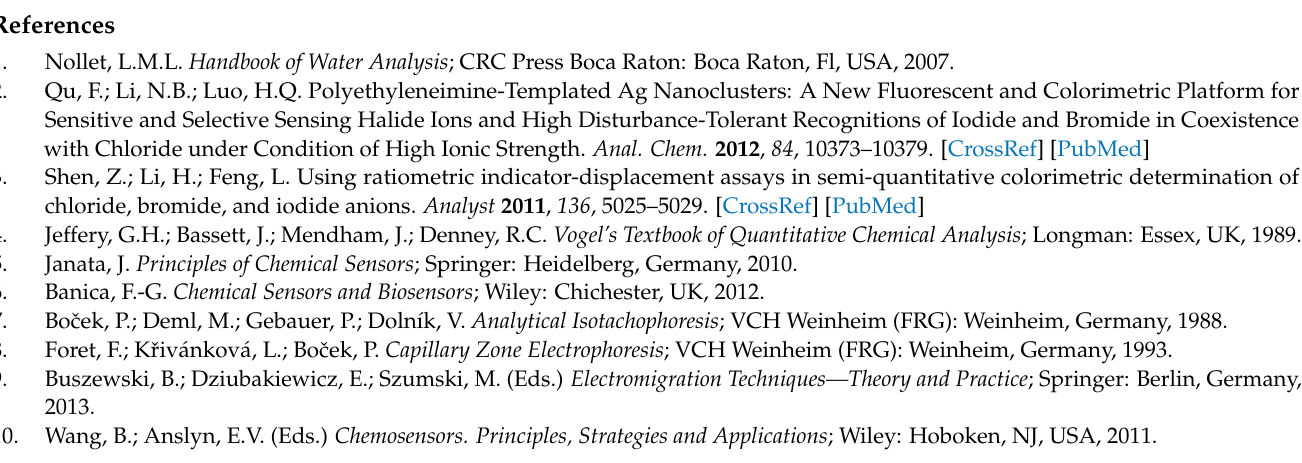
Therefore, the Equation (A12) can be used to estimate the conditional stability con- stants of TlL 2 complex from experimental data at pH ~ 4.0 (see Figure 3). The estimated value of conditional constant (log β (cid:48) (TlL 2 ) = 22.6—see Table A2) can be recalculated to thermodynamic value log β (TlL 2 ) = 25.8 (Tl(III)-PAR) using protonation constants of PAR (3.1, 5.6 [47]) which is comparable with value log β (TlL 2 ) = 26.6 (Tl(III)-PANS). Likewise, the conditional constant log β (cid:48) (TlL) = 16.3 (pH ~ 4.0) was calculated from the values for log β (TlL) = 17.9 [47]. Table A2. The equilibrium constants of exchange reactions of the system Tl(III)-PAR-halide (pH = 4.0).